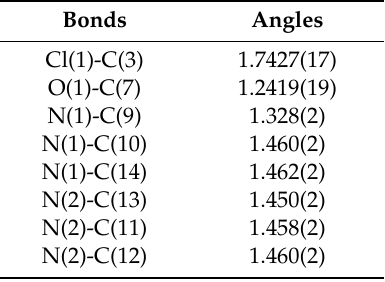
Table 2. Selected bond lengths [Å] and angles [ ◦ ] for 2 .